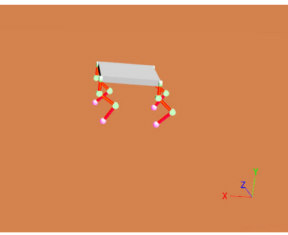
Figure 9. A simulation of the quadruped robot in Webots.